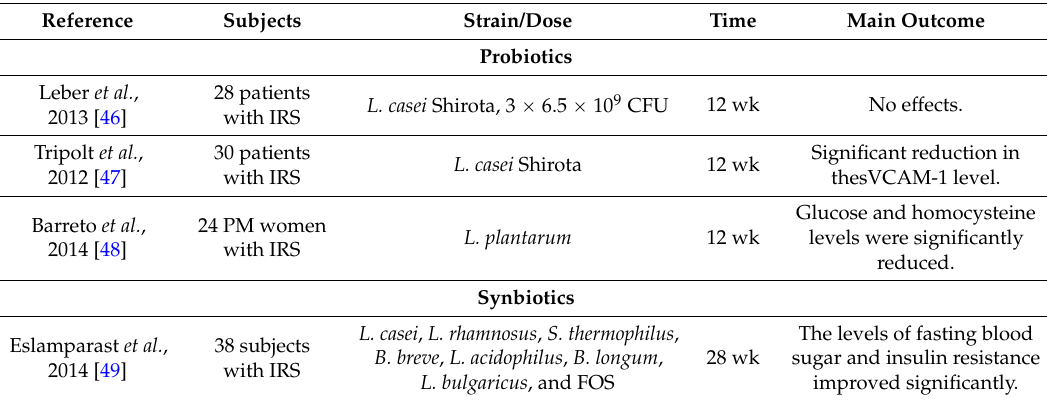
Table 2. Summary of randomized clinical intervention trials of probiotics and synbiotics in insulin resistance